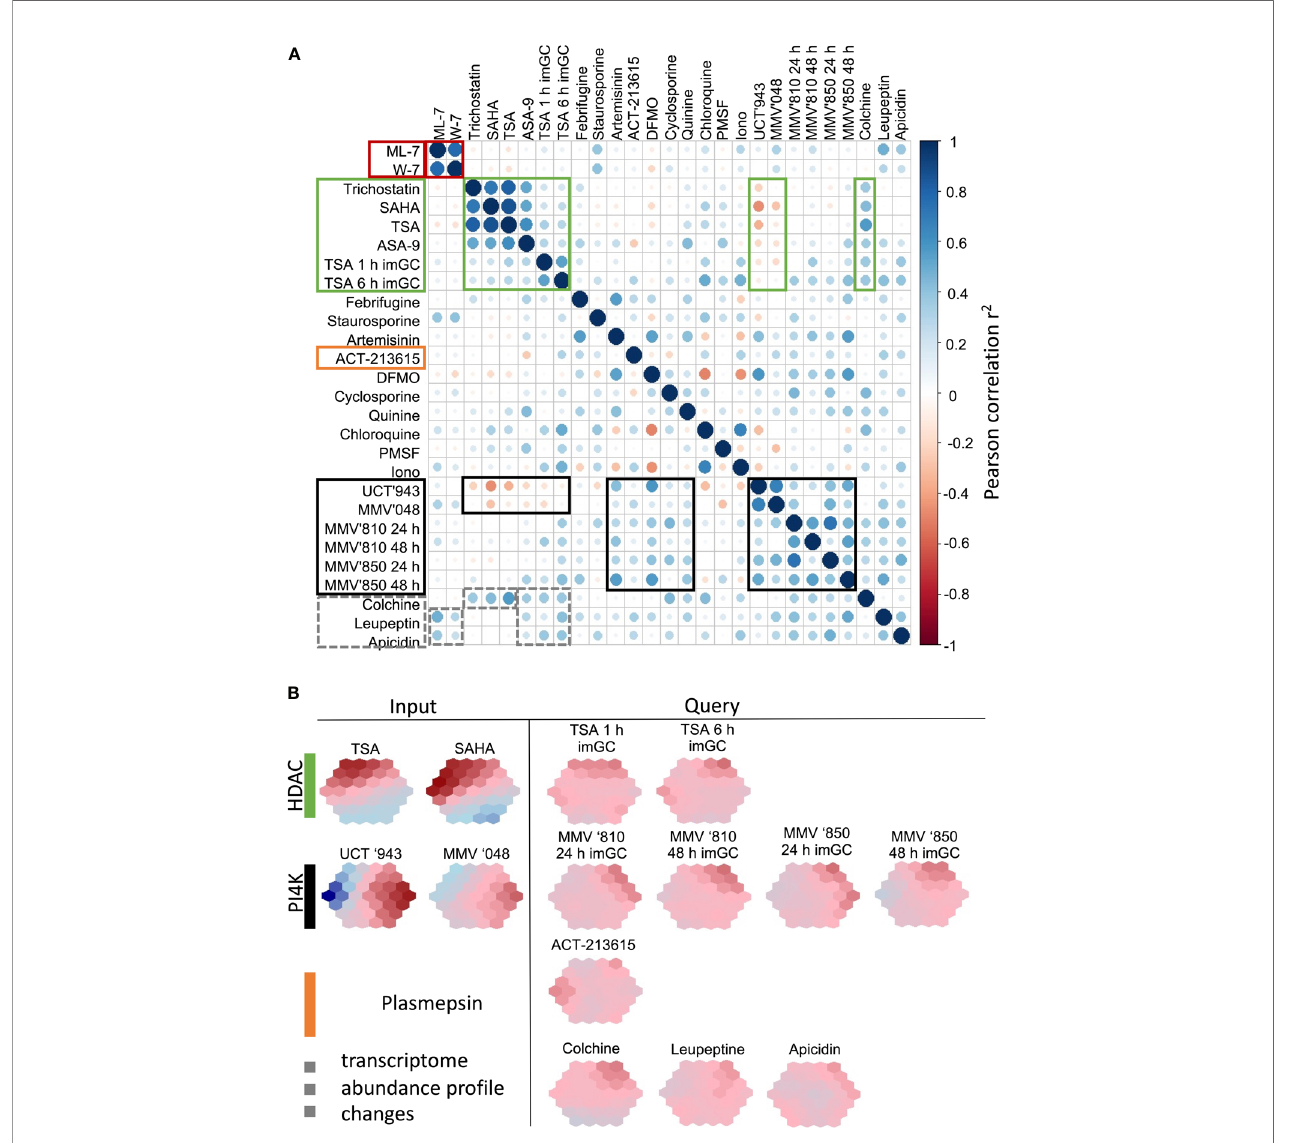
FIGURE 6 | Performance of the biomarkers to stratify new compounds to MoA classes. (A) Correlation plots were generated from biomarker expression pro fi les for compounds within our database as well as new compounds (TSA, MMV666810 and MMV642850) treated on immature gametocytes (stage II/III) to assess the usefulness of the biomarkers on different life cycle stages of the parasite. Plots were visualized using corrplot based on Pearson correlations. Similar correlation patterns, shown in blocks, were observed for compound treatments with similar MoA. Areas of high correlation (positive or negative) are indicated in blocks for particular compound groups. (B) SOM suprahexagonal chemo-transcriptomic fi ngerprints for each of the new compounds included in the validation compared to example compounds within the same MoA class. TSA, Trichostatin A; MMV666810, MMV ’ 810; MMV642850, MMV ’ 850; im Gc, immature stage II/III